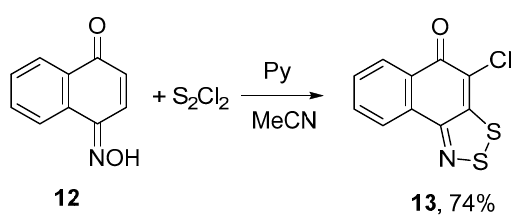
Figure 1. XRD molecular structure of dithiazole 13 (displacement ellipsoids at 50%, atoms H are shown as cycles). Selected bond distances (Å) and angles ( o ) (crystallographic numbering): C3-S1 1.7264(5), S1-S2 2.0774(5), S2-N1 1.6297(13), N1-C4 1.3054(19), C4-C3 1.456(2), C1-O1 1.2301(19),